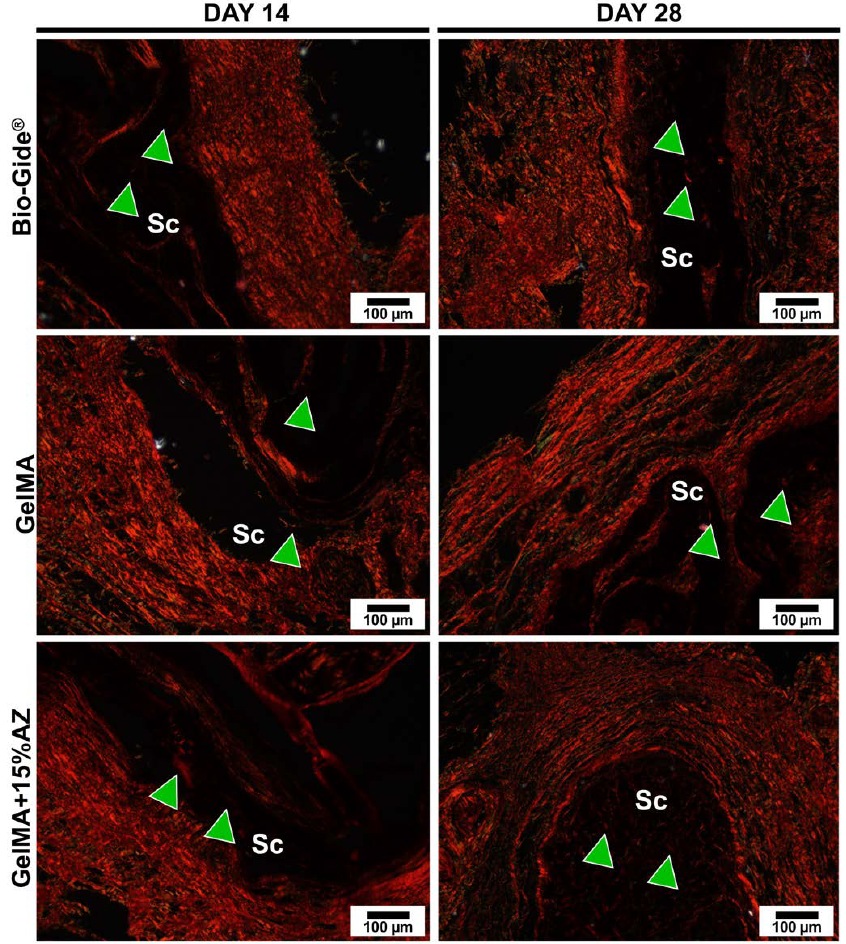
Figure 6. Representative Picrosirius Red stained slices for the implanted scaffolds in rat’s subcuta- neous tissue at 14 days and 28 days. Original magnification: 10× (scale bar = 100 µm). Scaffold: Sc, Red fibers considered as mature and thick interspersing the scaffold: green arrowhead. On day 28, note the presence of mature collagen fibers interspersing the area initially occupied by the scaffold.